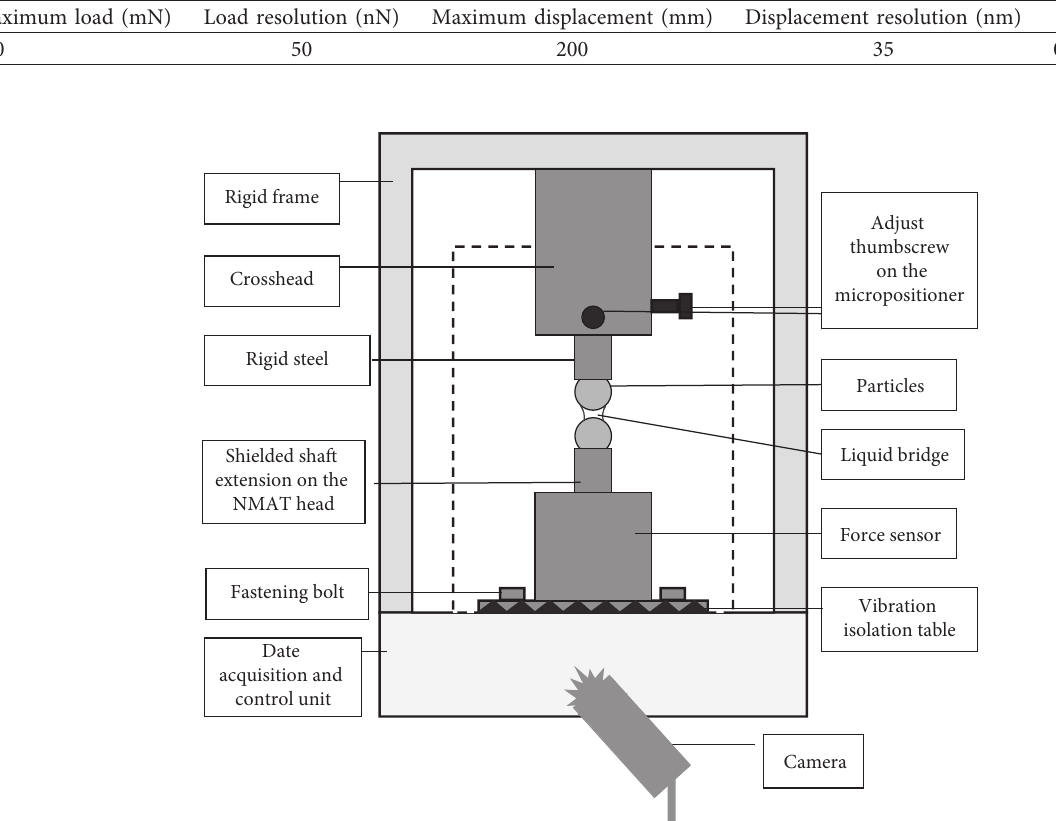
Table 1: The main mechanical parameters of the Nano UTM T150.